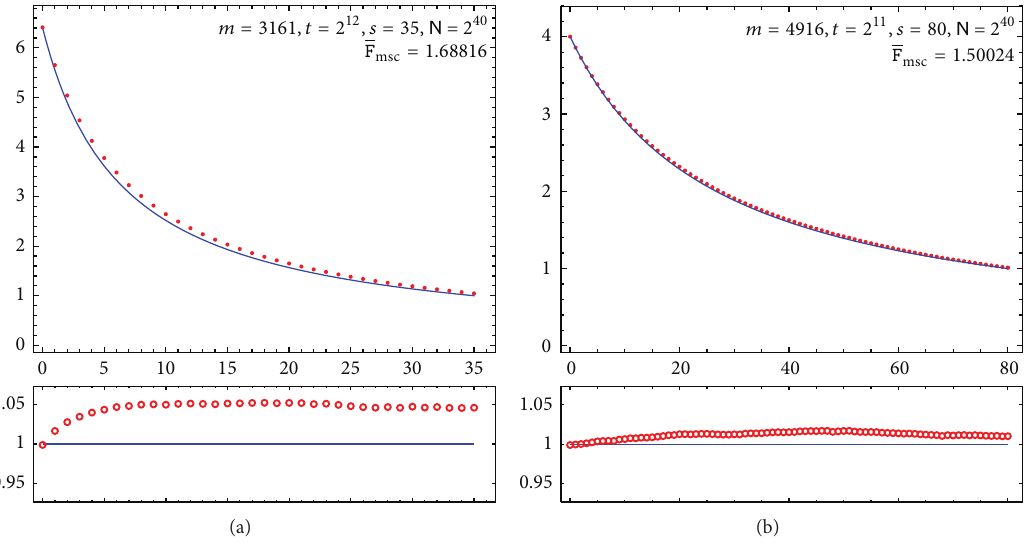
Figure 6: Number of 𝑖 th color boundary points in a fuzzy rainbow matrix ( line : theory; dots : test; circles : test/theory; 𝑥 -axis: 𝑖 ; 𝑦 - axis: 𝑚 𝑖 /𝑚 and test/theory